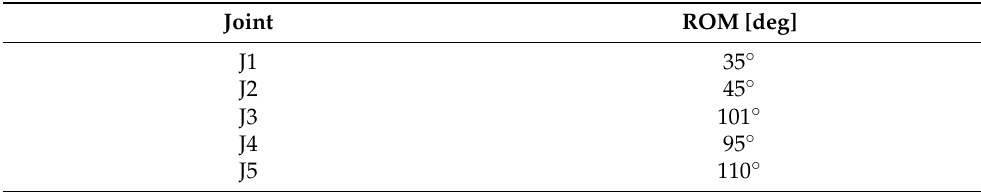
Table 3. Range of motion of the exoskeleton joints.